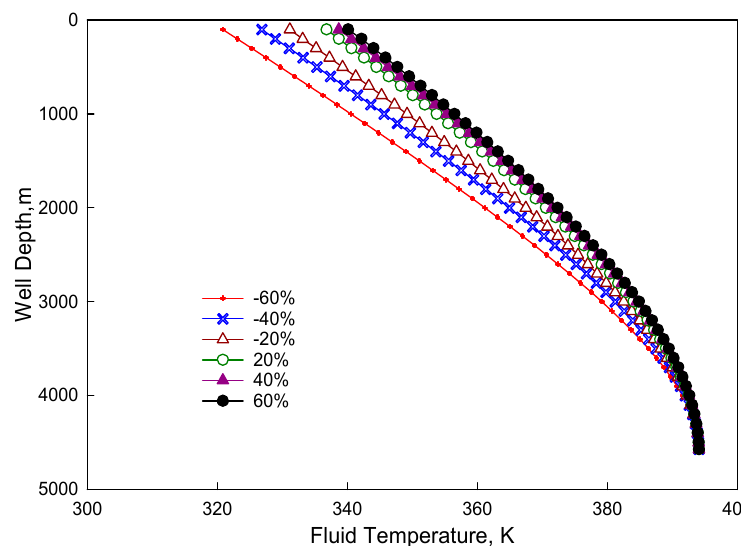
Figure 3. Effect of oil flow rate on the temperature distribution curve in the tubing.